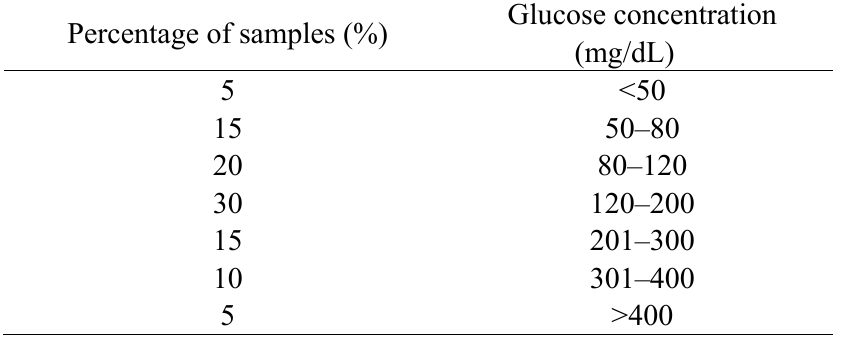
Table 3. Glucose concentrations of samples for the evaluation of system accuracy